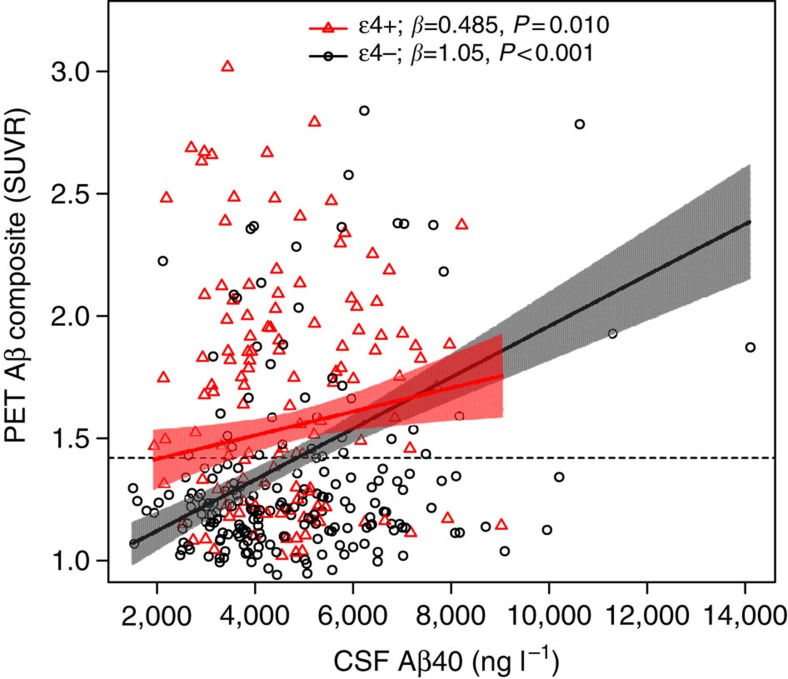
PET Aβ as a function of CSF Aβ40 and APOE ɛ4.Observed PET and CSF Aβ40 data. Slopes are modelled from a linear regression adjusted for CSF Aβ42, sex, age and diagnostic group. The shaded areas indicate 95% confidence intervals for the slopes. The dotted line indicates a cutoff for clinically significant PET Aβ load (1.42 SUVR). β-coefficients (divided by 10−4) and P values for the slopes within APOE ɛ4-positive and separately for APOE ɛ4-negative subjects are shown in the legend. The interaction between CSF Aβ40 and APOE ɛ4 is significant, indicating that the correlation between CSF Aβ40 and PET Aβ differs by APOE ɛ4 status (P=0.0080). The results did not change significantly when removing outliers (CSF Aβ40>10,000 ng l−1).